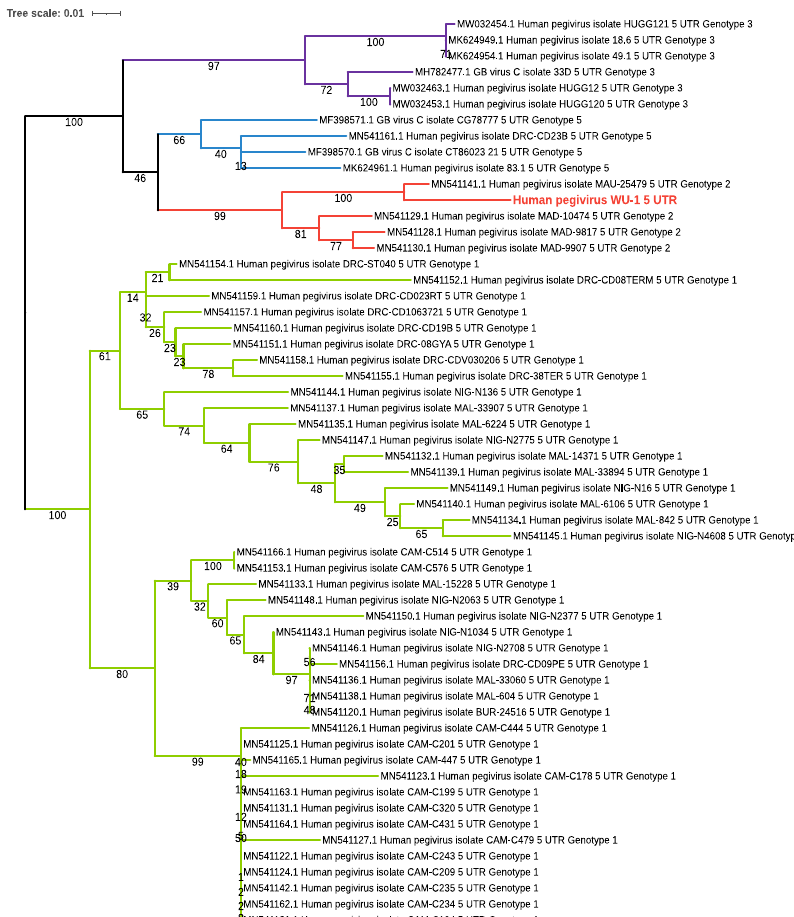
Figure 2. The human pegivirus sequenced in the first trimester maternal plasma samples shows high homology to HPgV-1 genotype 2. The 5 ′ UTR of the newly sequenced pegivirus genomes were compared to publicly available, curated genotyped 5 ′ UTR sequences (MN541120-MN541174) and supplemented with and additional sequences from GenBank to add genotype representation (MW032463.1, MW032454.1, MW032453.1, MK624961.1, MK624954.1, MK624949.1, MF398571.1, MF398570.1, and MH782477.1). Clades representing genotypes 1 (green), 2 (red), 3 (purple), and 5 (blue) are shown. The sample from this study is in the genotype 2 clade and is labeled in red font. Bootstrap values are shown on each branch.